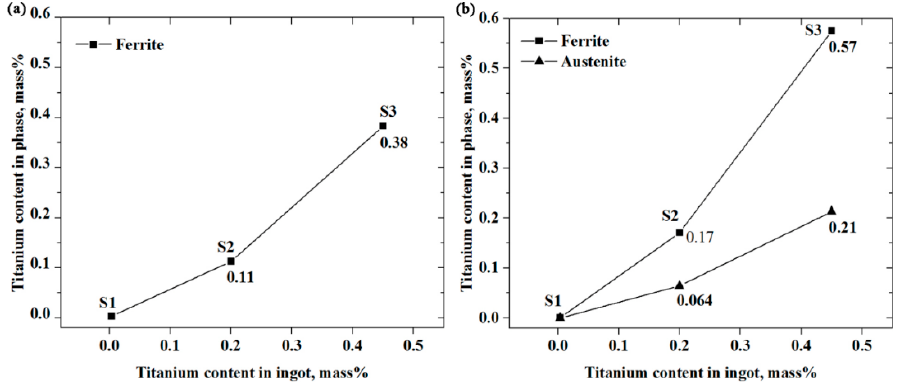
13 of 16 Figure 14. Scheil solidification calculation result for 20Cr-8Ni stainless steel: ( a ) S1; ( b ) S2; and ( c ) S3. 4.2. Effect of Titanium on Microstructure To evaluate the effect of titanium content on the microstructure of 20Cr-8Ni stainless steel, it was necessary to discuss the formation of auetenite durnig the solidification process or after the solidification process. On the basis of the equilibrium solidification process shown in Figure 13, the austenite formed through peritectic or eutectic reaction at the end of solidification process in ingot S1. The equilibrium solidification model of ingot S1 was the FA model (liquid → liquid + δ -ferrite → liquid + δ -ferrite + γ -austenite → δ -ferrite + γ -austenite). Liang et al. also indicated that the equilibrium solidification model of AISI 321 stainless steel was the FA model, according to the ratio of Ni equivalent and Cr equivalent [33]. In ingot S2 and ingot S3, the austenite formed after solidification, and the equilibrium solidification model was the F model (liquid → liquid + δ -ferrite → δ -ferrite). During the scheil solidification process shown in Figure 14, the austenite in ingot S1, S2, and S3 formed during solidification owing to element segregation. However, the solid fraction at which austenite precipitated increased with titanium addition. It could be concluded that titanium prevented the precipitation of austenite in 20Cr-8Ni stainless steel. According to Hammar and Svensson equivalents shown in Equations (1) and (2), the solidification models of ingot S1, S2, and S3 were all the F model [34]. This meant that equilibrium solidification calculated through Thermo-Calc software was more reliable. On the basis of the equilibrium solidification process, the soluble titanium content in ferrite and austenite at different temperatures was calculated. The results are shown in Figure 15. Figure 15a shows the soluble titanium content in ferrite when austenite began to form. T A was the temperature at which austenite began to form. With soluble titanium content in ferrite increasing through S1, S2, and S3, the stability of ferrite increased gradually. Moreover, transformation of ferrite to austenite retarded. Figure 15b shows the soluble titanium content in ferrite and austenite at 1100 °C. The solution treatment temperature for 20Cr-8Ni stainless steel in industrial practice was around 1100 °C.The content of soluble titanium in ferrite increased through S1, S2, and S3, and was higher than austenite, which